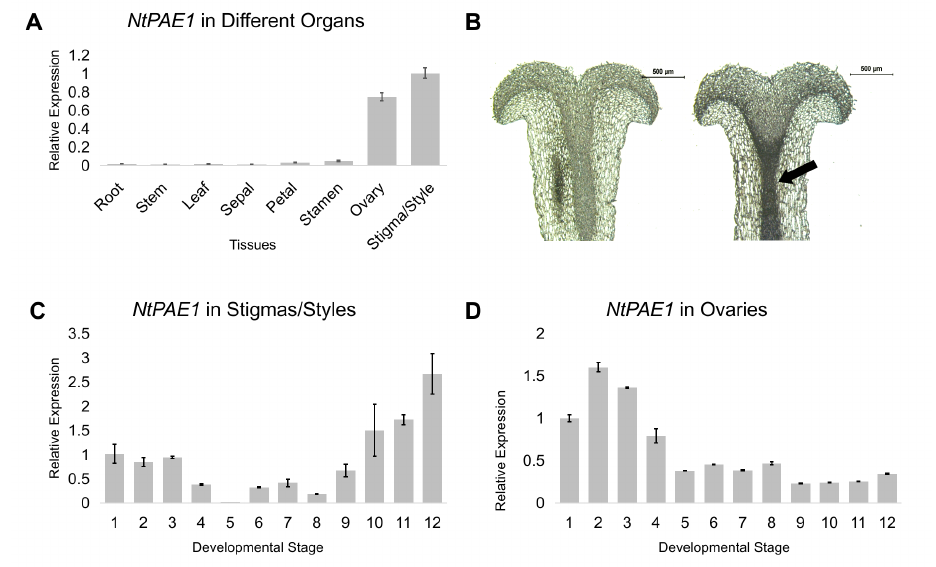
Figure 1. Expression of NtPAE1 in floral organs of tobacco. ( A ) Relative expression levels of Nt- PAE1 by RT-qPCR in different tobacco tissues. ( B ) In situ hybridization of NtPAE1 in stigma/style section. Left = sense NtPAE1 probe; Right = antisense NtPAE1 probe. Bars = 500 µm. ( C ) Relative expression levels of NtPAE1 in stigmas and styles in different flower developmental stages (according to Koltunow et al. [38]). ( D ) Relative expression levels of NtPAE1 in ovaries in different flower developmental